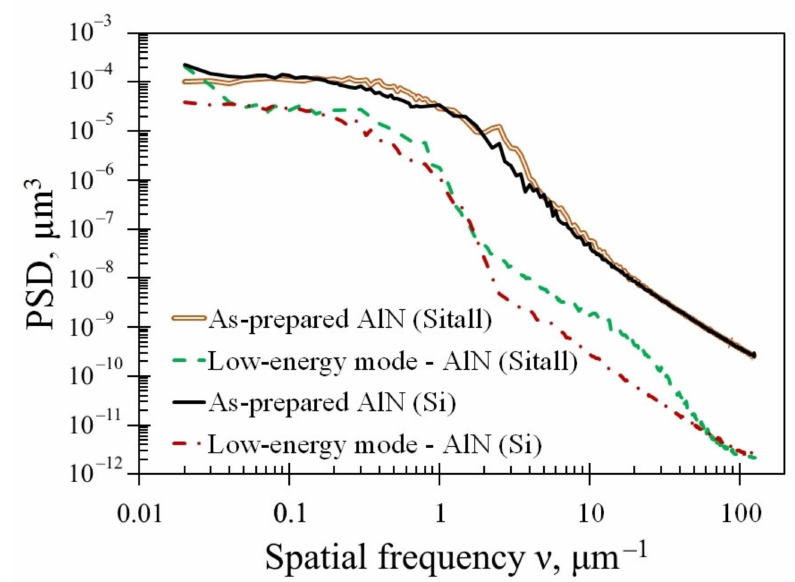
Figure 4. PSD functions of the roughness of the AlN surface before and after cluster ion treatment on the different substrates. Table 1. The roughness parameters of AlN thin